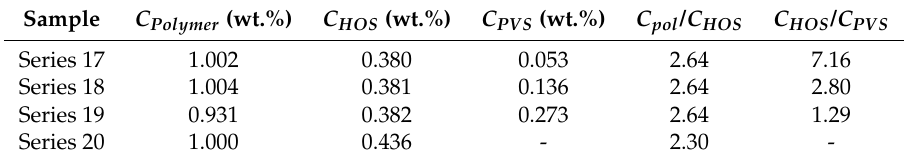
Table 3. Composition of polymer/polyelectrolyte complex (PEC) sample series with the concentrations in